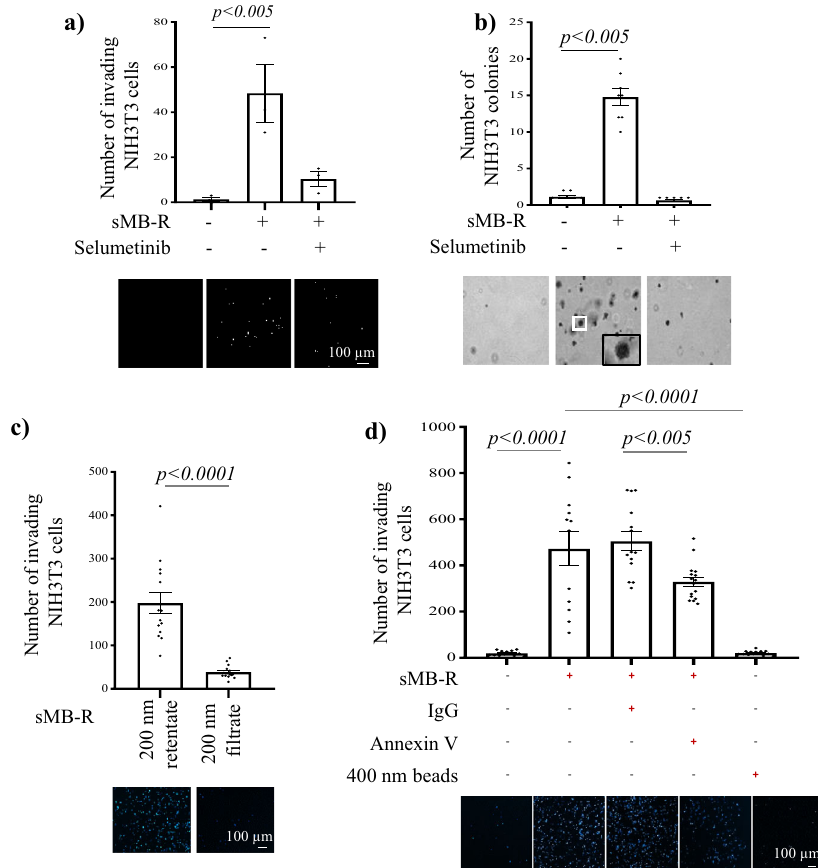
Fig. 5 Cancer cell-derived shed midbody remnants induce invasive/transformed phenotype in NIH3T3 fi broblasts. a sMB-Rs confer invasive capability in NIH3T3 fi broblasts. Transwell-Matrigel TM invasion assay of NIH3T3 cells treated with SW620-derived sMB-Rs NIH3T3 fi broblasts were incubated with SW620 cell-derived sMB-Rs (30 µ g ml − 1 ) for 2h and overlaid onto Matrigel TM matrix coated inserts on a Transwell invasion assay and the number of invading cells quanti fi ed. Data represented as mean±s.e.m. b sMB-Rs confer anchorage-independent growth capability in NIH3T3 fi broblasts. Soft agar colony formation assay of NIH3T3 treated with SW620-derived sMB-Rs. NIH3T3 fi broblasts were incubated with SW620 cell-derived sMB-Rs (200 µ g ml − 1 ) for 2h and then grown in 0.6% soft-agar suspension in a soft agar colony formation assay. Data represented as mean±s.e.m. c Transwell-Matrigel TM invasion assay of NIH3T3 cells treated sMB-Rs obtained using size-based puri fi cation (0.22 μ m pore size fi lter). The fi ltrate ( fl owthrough that contains small EVs (30 – 150 nm) and soluble protein contaminants) and the retentate (containing larger sMB-Rs) were used to assess fi broblast invasion. Data represented as mean±s.e.m. Lower panel: fl uorescence microscopy images of nuclei (stained with Hoechst) of invasive fi broblasts. d Transwell-Matrigel TM invasion assay of fi broblasts treated with by sMB-R fraction depleted of sMB-Rs using biotin-Annexin V or 400nm Polystyrene latex bead. Data represented as mean±s.e.m. Lower panel: fl uorescence microscopy images of nuclei (stained with Hoechst) of invasive fi broblasts. COMMUNICATIONS BIOLOGY| (2021) 4:400